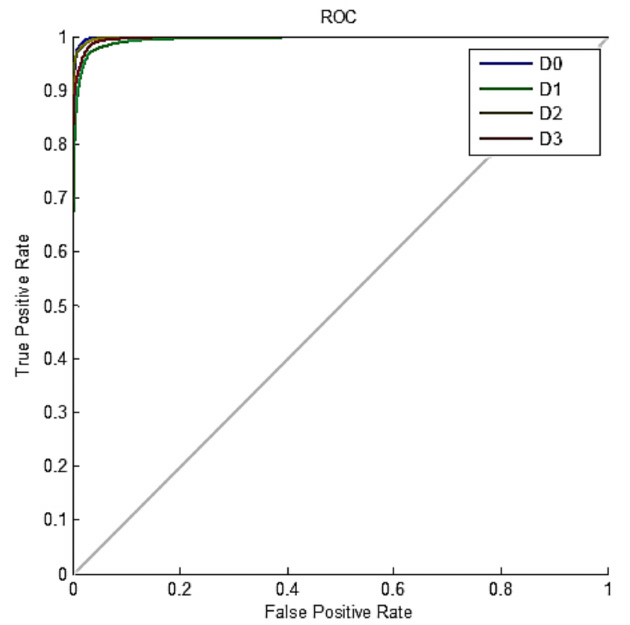
Figure 9. ROC curves of the ANN-ICA classifier at 200 repetitions for the four